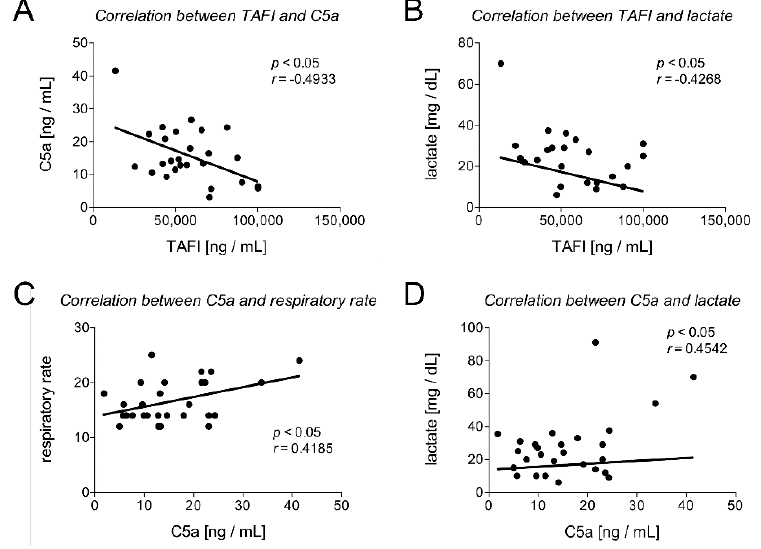
Figure 3. Correlation analysis between TAFI and C5a ( A ), TAFI and lactate ( B ), C5a and respiratory rate ( C ), and C5a and lactate ( D ) are shown. r : Pearson coefficient. Table 5. Receiver-operator curve (ROC) analyses on TAFI, C5a, leukocyte count, lactate level, heart rate, and respiratory rate at admission to the emergency department to predict the development of sepsis after polytrauma. Sensitivity and specificity are given as percentage values. Abbreviations: AUC, area under the curve and CI, confidence